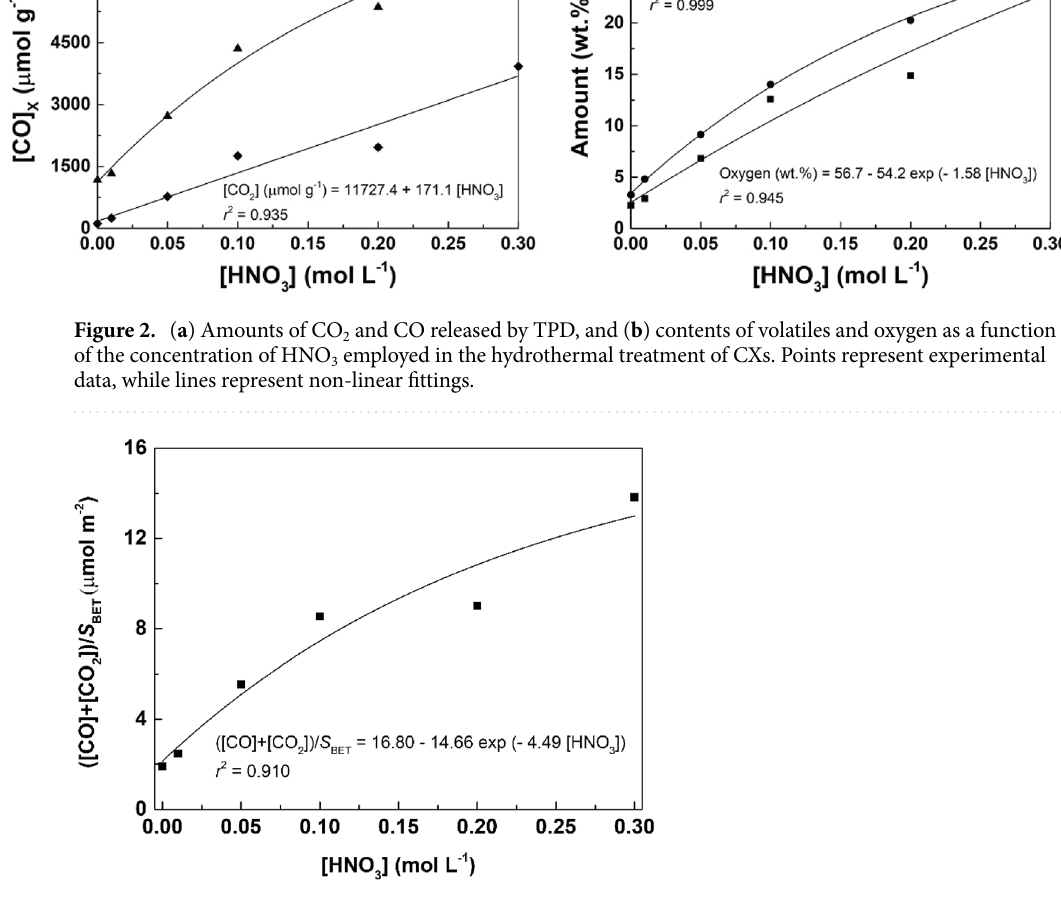
Figure 3. ([CO 2 ] + [CO])/ S BET as a function of HNO 3